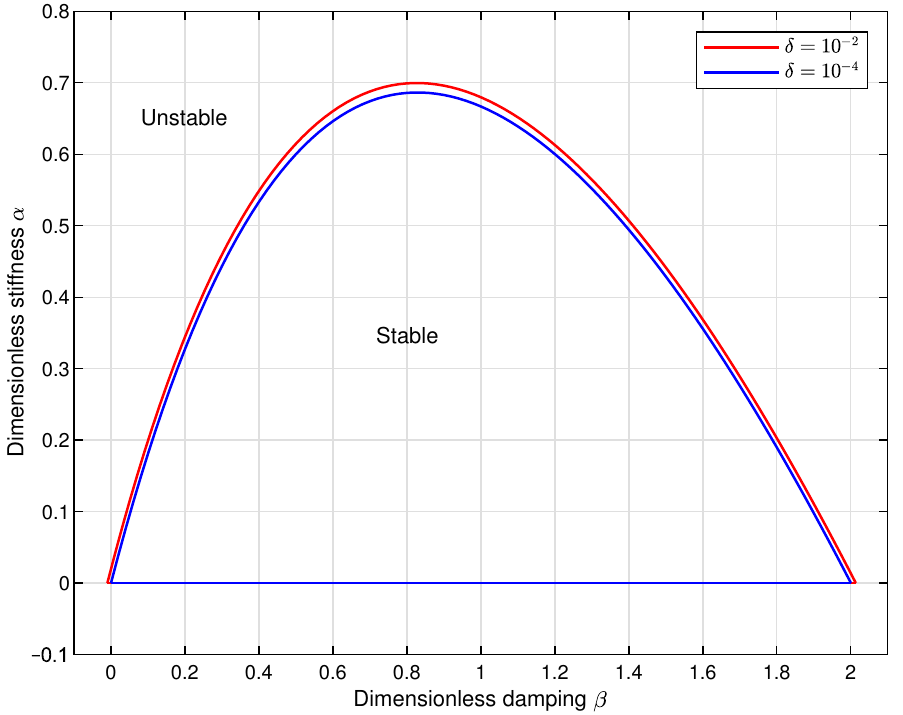
Figure 2. Stability boundaries for virtual spring-damper